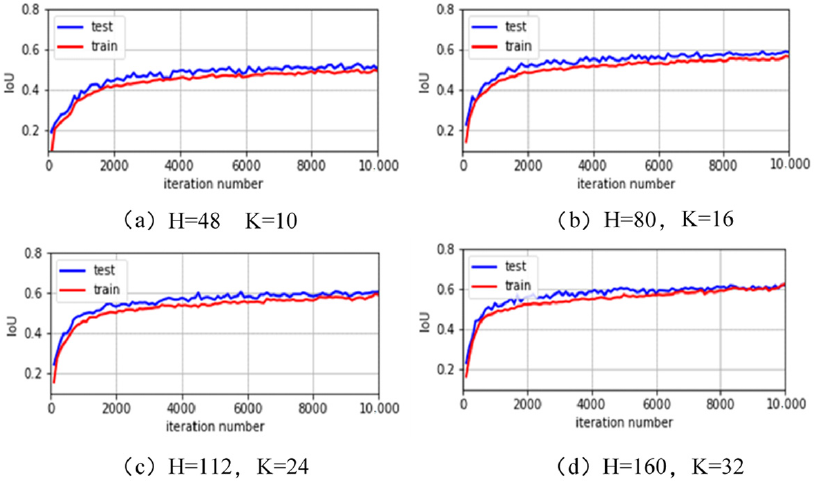
Figure 7. Training curves of IoU with different parameters.